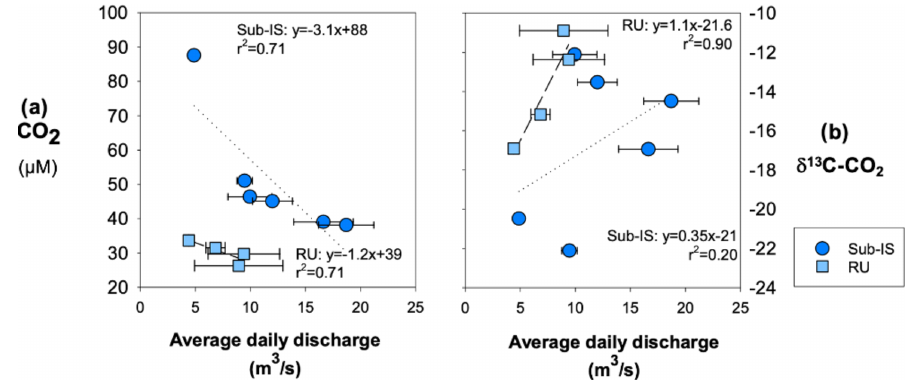
Figure 8. Relationships between average daily discharge (a) CO 2 concentrations and (b) δ 13 C-CO 2 . Regressions are shown by dotted lines for sub-Isunnguata and dashed lines for Russell samples. Horizontal error bars represent the standard deviation of average daily discharge for days samples were collected and are smaller than symbols for some data